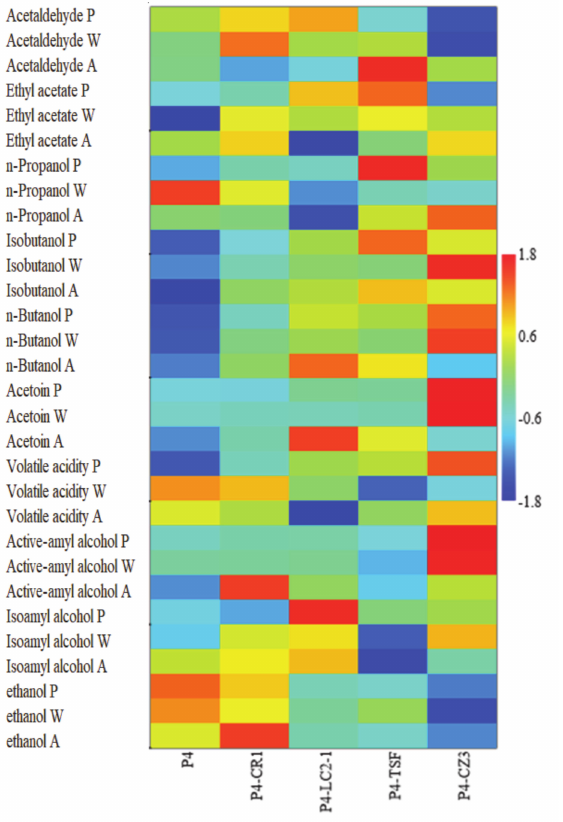
Figure 4. Heatmap based on all the analytical parameters detected in experimental beers obtained by mixed starters (P4-CR1; P4-LC2-1; P4-TSF and P4-CZ3) and the single strain (P4) in Pilsner (P), Weizen (W) and Amber (A) fermentations, together with their corresponding single-strain control (P4). Colours represent the range of calculated Z- scores (calculated over the rows and for each fermentation medium), with blue indicating lower than average production, light green indicating average production and red indicating higher than average production of each